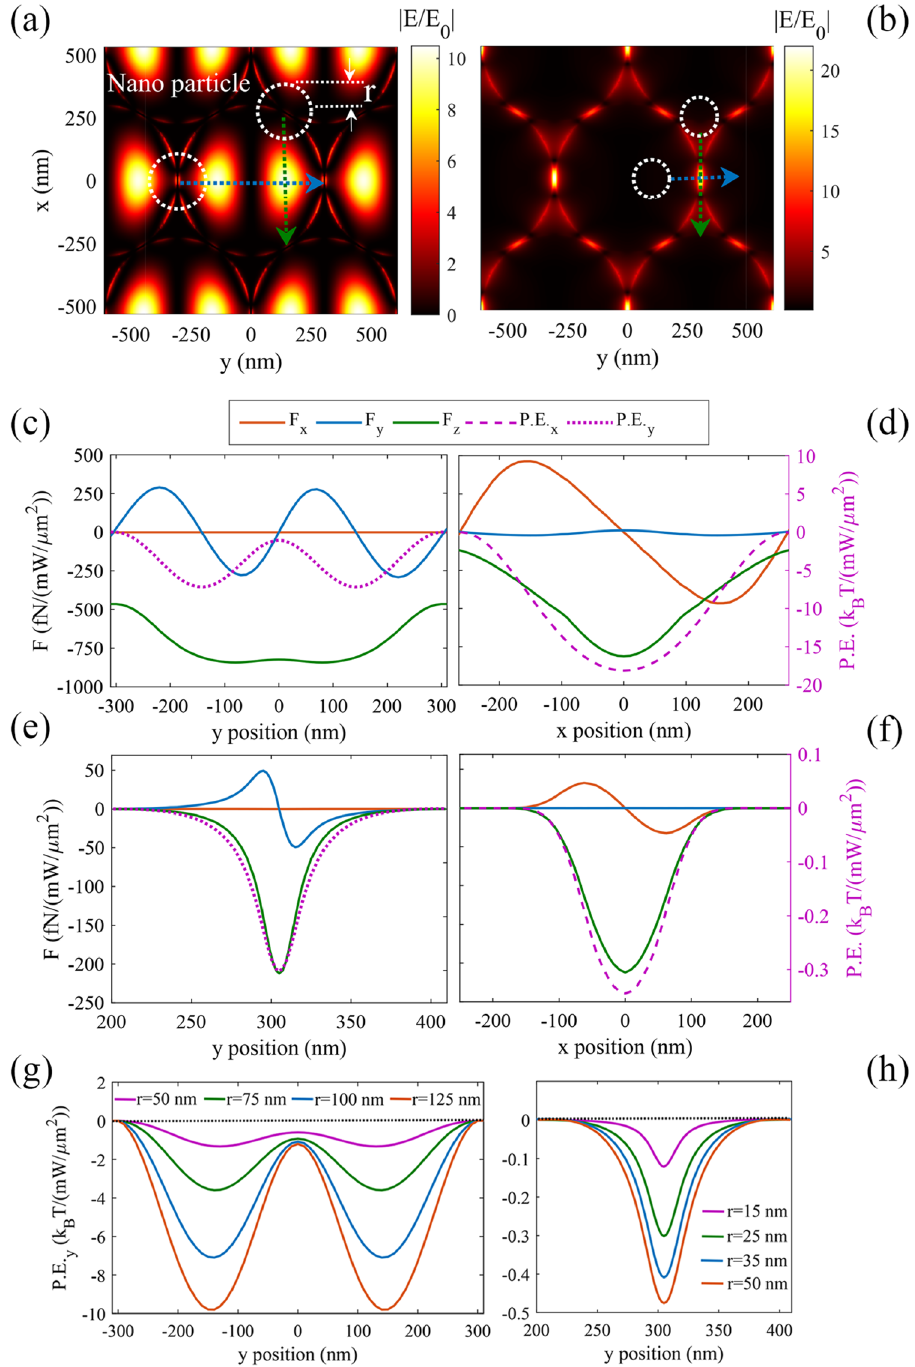
Figure 6. The investigated particle motion directions with respect to the plasmonic field distributions for ( a ) LSPM, and ( b ) DSPM. The white dotted circles show the particles, while the blue and green dotted arrows show the particle motions along the y and x directions, respectively. The exerted plasmonic force components and the resulting potential energies are presented versus the particle position along the x and y axis, for polystyrene spheres with ( c , d ) r = 100 nm and LSPM excitation, and ( e , f ) r = 25 nm and DSPM excitation, at fixed z = 50 nm. ( g ) LSPM, and ( h ) DSPM potential energies for polystyrene particles with different radii, when the particle is moved along the y direction at z = 50 and x = 0